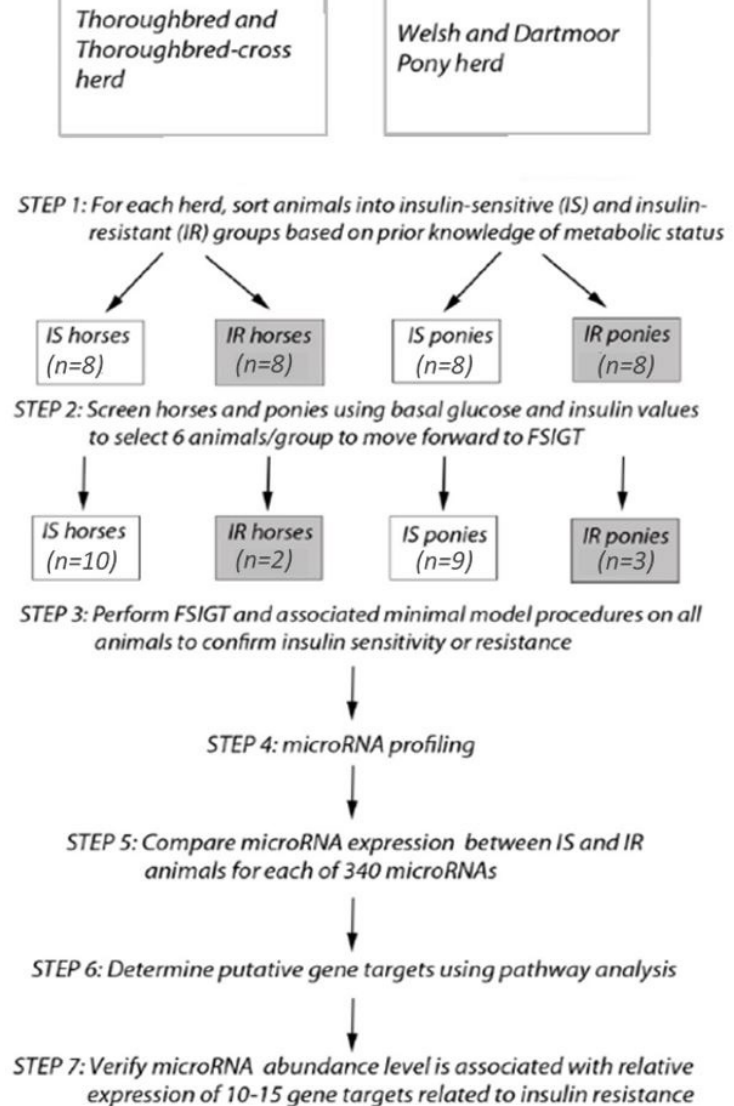
Figure 1. Schematic illustration of research protocol used in this